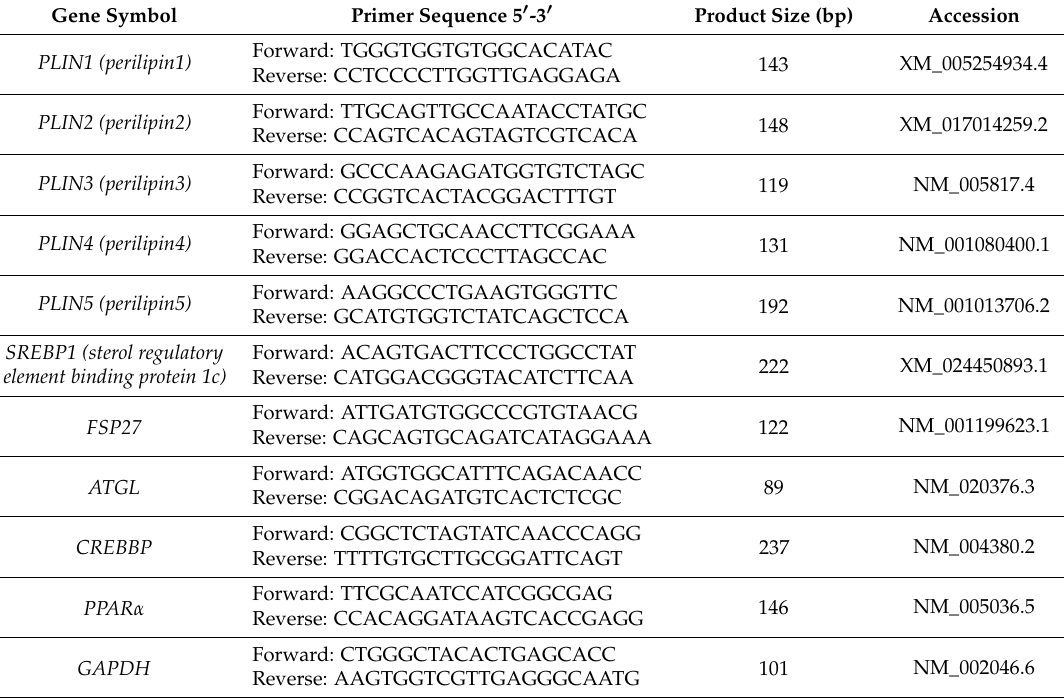
Table 1. Primer used for SYBR Green I qRT-PCR